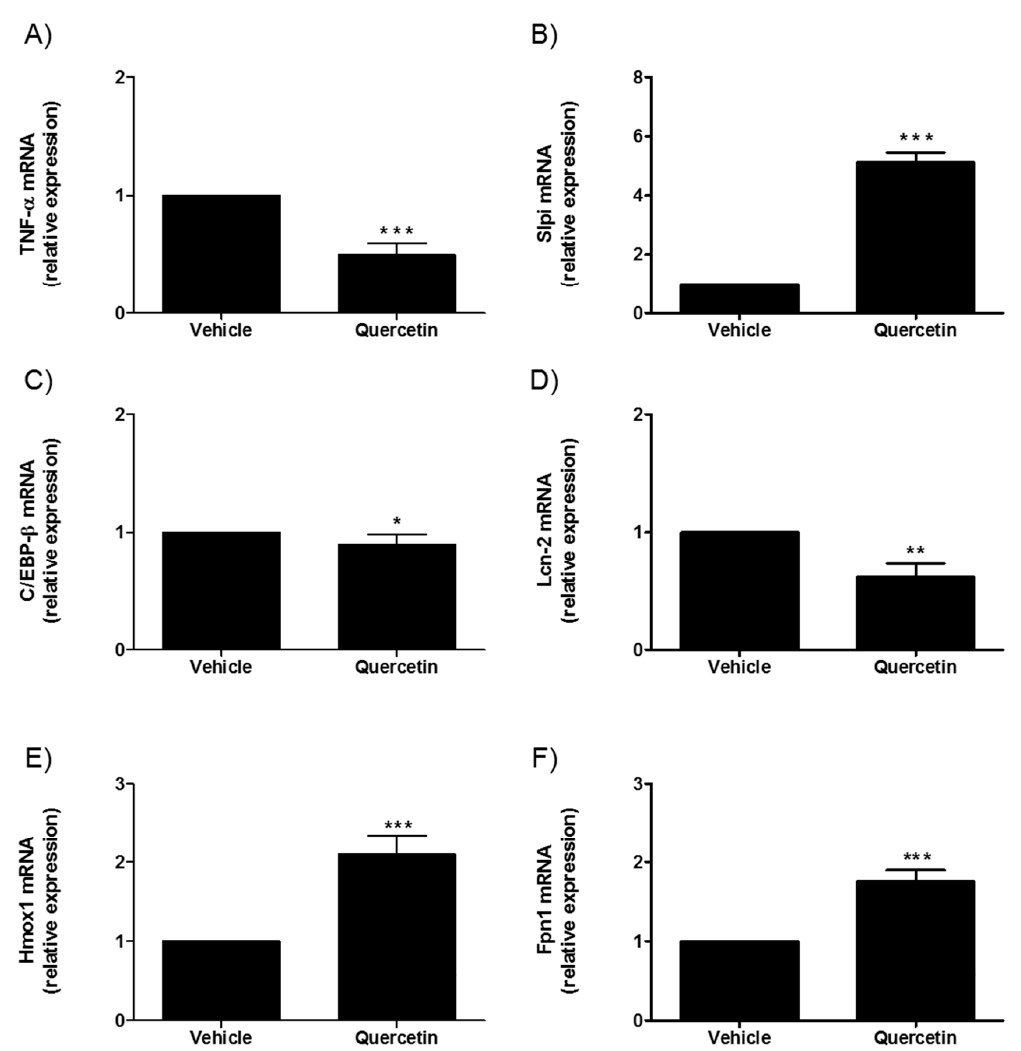
Figure 7. Effect of quercetin on small-intestinal UC-organoids. Expression of TNF- α ( A ), Slpi ( B ), C/EBP- β ( C ), LCN-2 ( D ), Hmox ( E ), and Fpn1 ( F ) was detected by real-time PCR. Relative expression of selected genes was calculated relative to untreated UC-organoids. Histograms represent mean expression ± SEM of four independent experiments. Unpaired two-tailed Student’s t-test was used for statistical analysis. *** p < 0.001, ** p < 0.01, * p < 0.05.